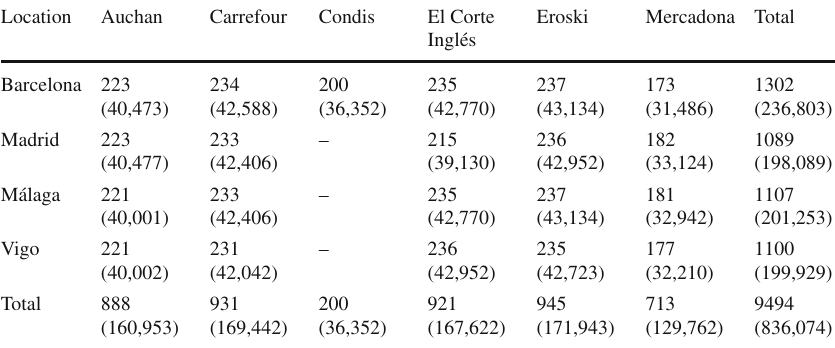
Table 8 Number of products (observations) in each location and